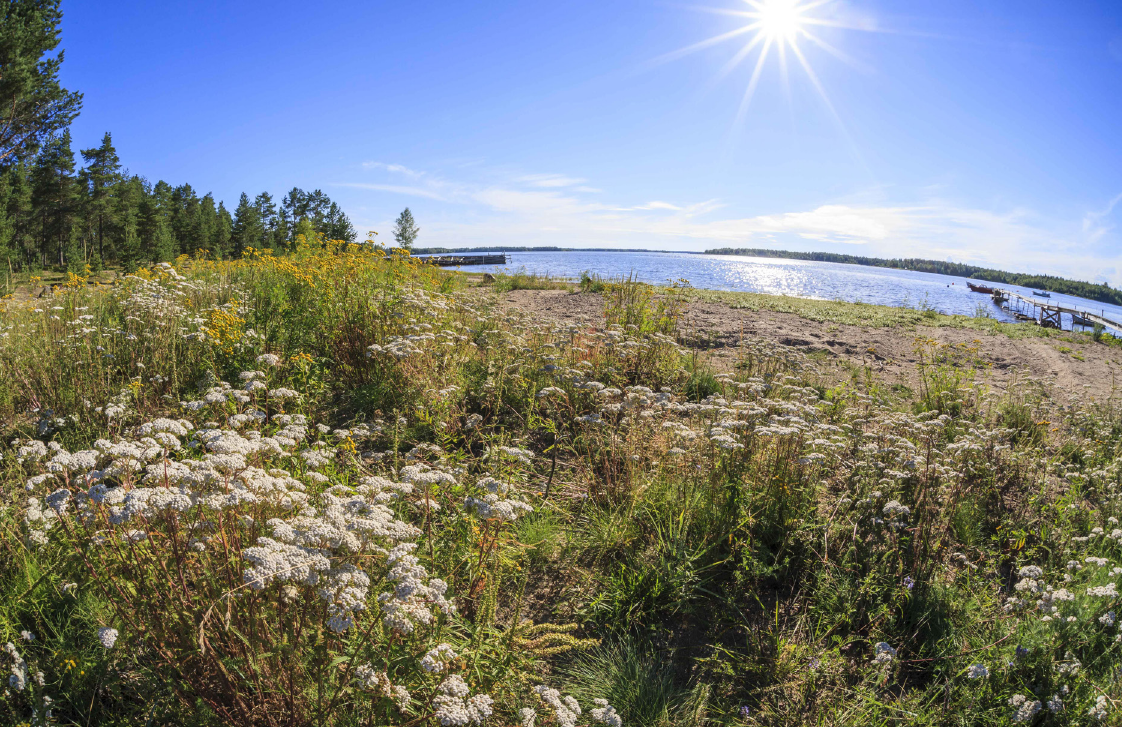
Fig. 13. Seashore along the Baltic sea at Haparanda Santasaari, type locality for Homotropus klopfsteinae sp. nov. Photo: Nils